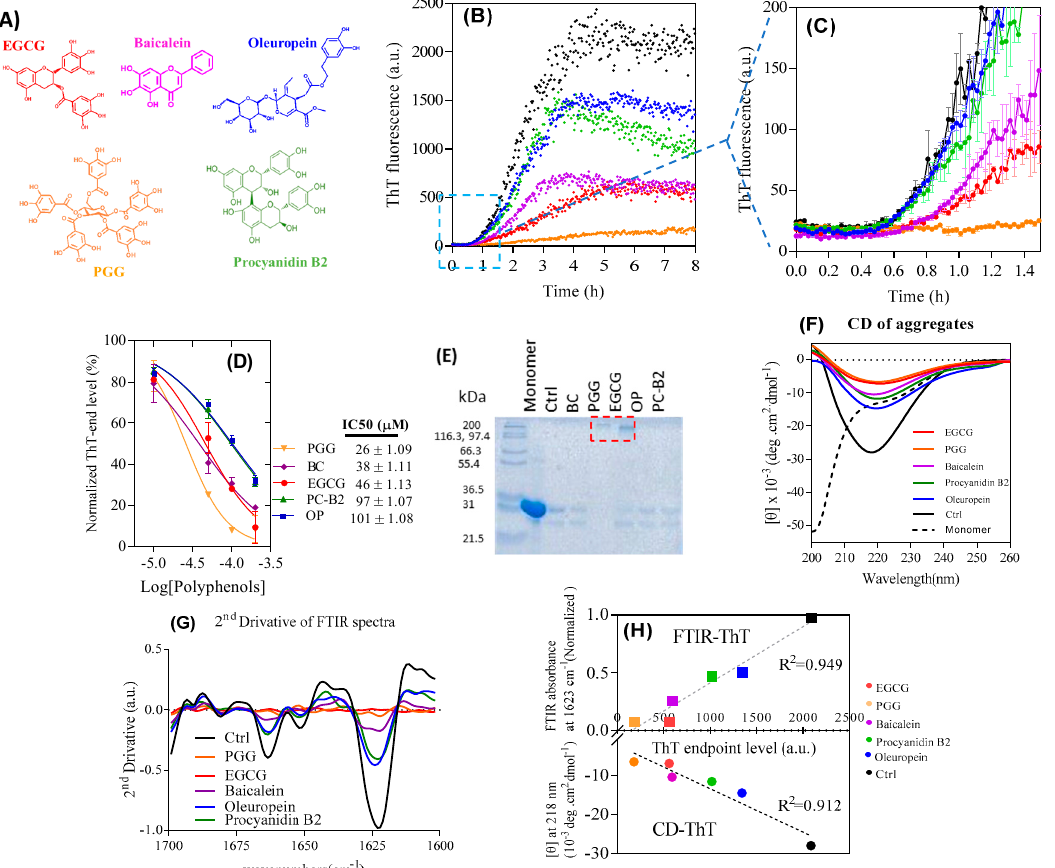
Figure 1. E ff ect of polyphenols on fibrillation-prone protein (FapC)- UK4 fibrillation. ( A ) Structures of compounds used in this study. Compound colors correspond to the label colors in subsequent graphs; ( B ) time course of fibrillation of 30 µ M FapC with 100 µ M polyphenols at pH 7.5 and 37 ◦ C monitored by Thioflavin T (ThT) fluorescence ( C ) and zoom-in in (A); ( D ) IC50 values for inhibition of fibrillation based on data in panel b; ( E ) SDS-PAGE of samples after incubation with polyphenols. Red box highlights the oligomer band; ( F ) Circular Dichroism (CD) and ( G ) ATR-FTIR of samples from panel A after the end of incubation. 1623 and 1663 cm − 1 peaks are attributed to β -sheet; ( H ) correlation between ATR-FTIR / CD and ThT endpoint levels.